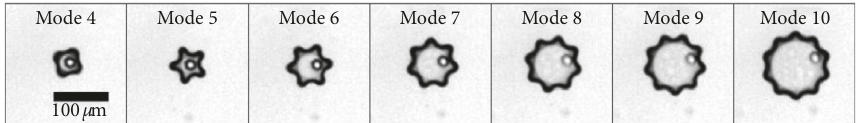
Figure 2: Snapshots of a bubble oscillation under high amplitude of ultrasound [20].